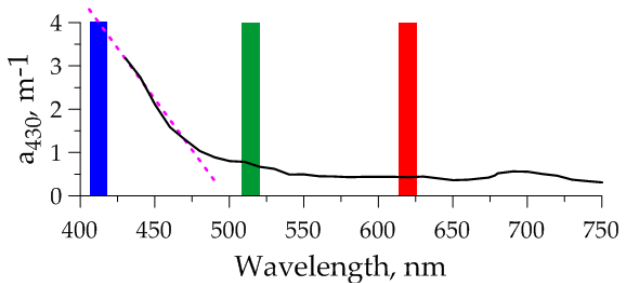
Figure 9. Spectral absorption coefficient of the Gorky Reservoir (black line); dotted curve corresponds to the extension into the short-wave part and colored rectangles indicate the bandwidth of the used color filters.